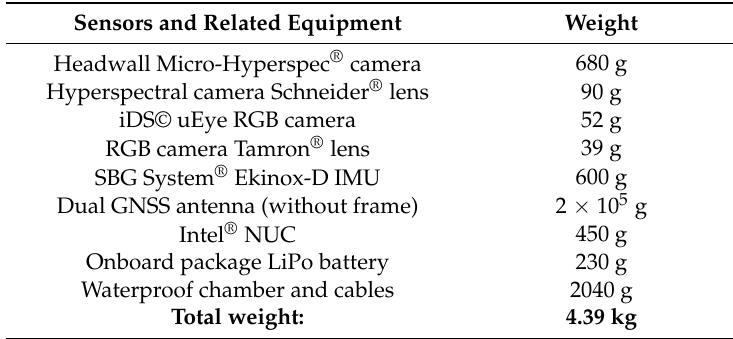
Table 1. Weights of the embedded sensors. GNSS: Global Navigation Satellite System.